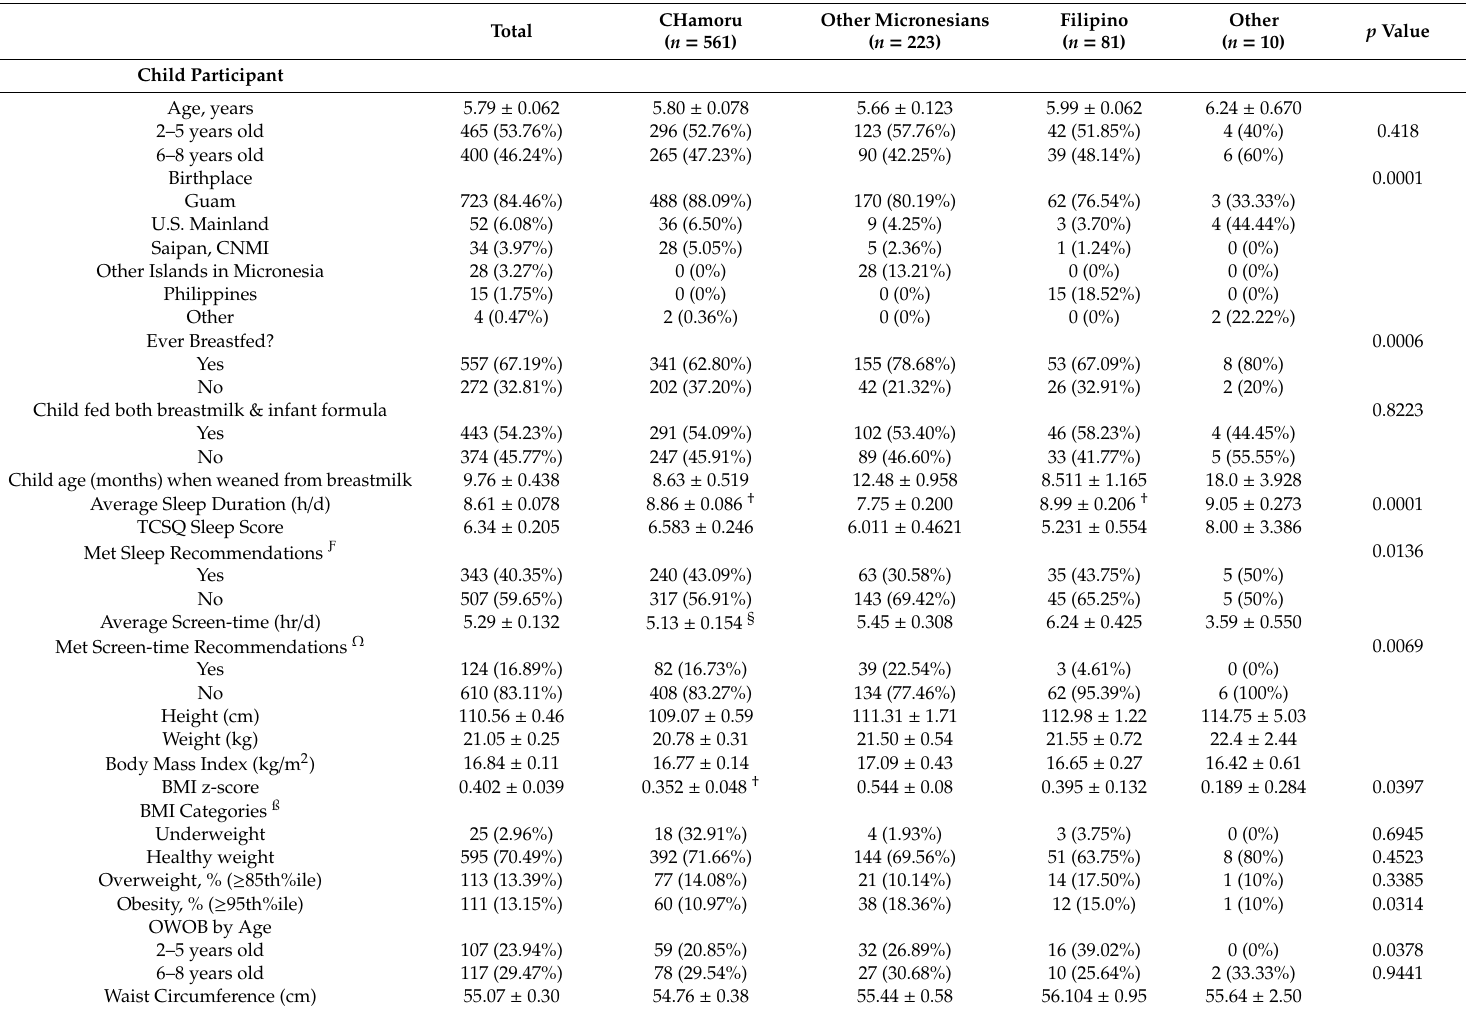
Table 1. Characteristics * of child participants from Guam in the Children’s Healthy Living (CHL) Program by